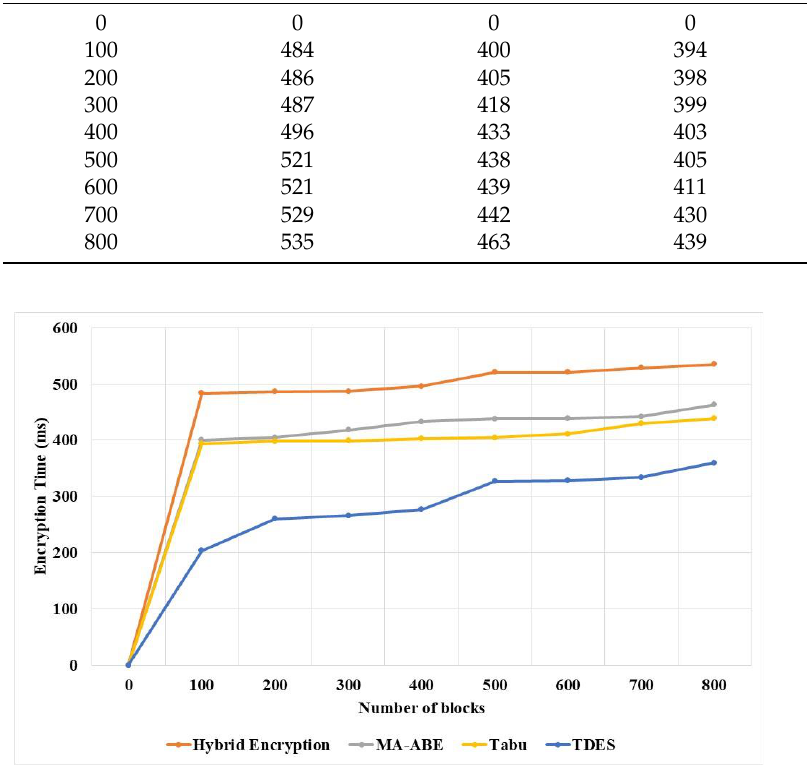
Figure 7. TDES and existing techniques encryption time for various numbers of blocks.